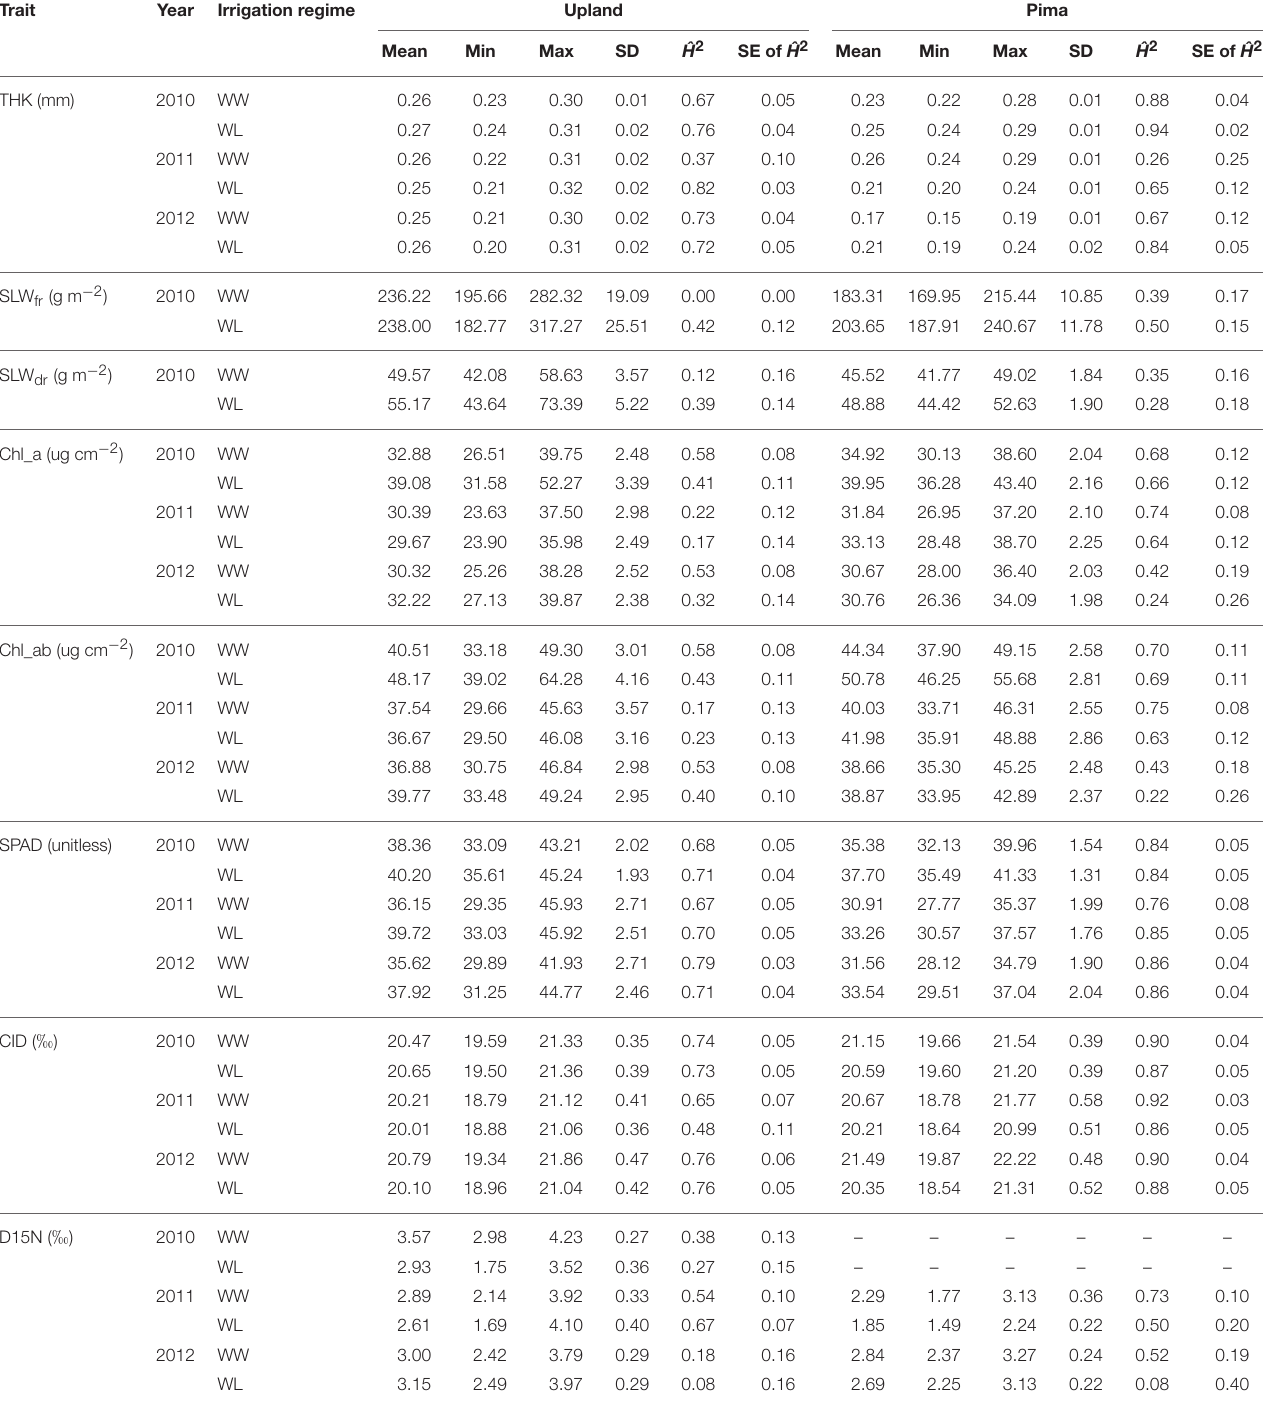
TABLE 1 | Mean, minimum, maximum, and standard deviation of best linear unbiased estimators (BLUEs) for traits evaluated for the upland recombinant inbred line (RIL) and Pima populations tested under two irrigation regimes, water-limited (WL) and well-watered (WW) conditions.